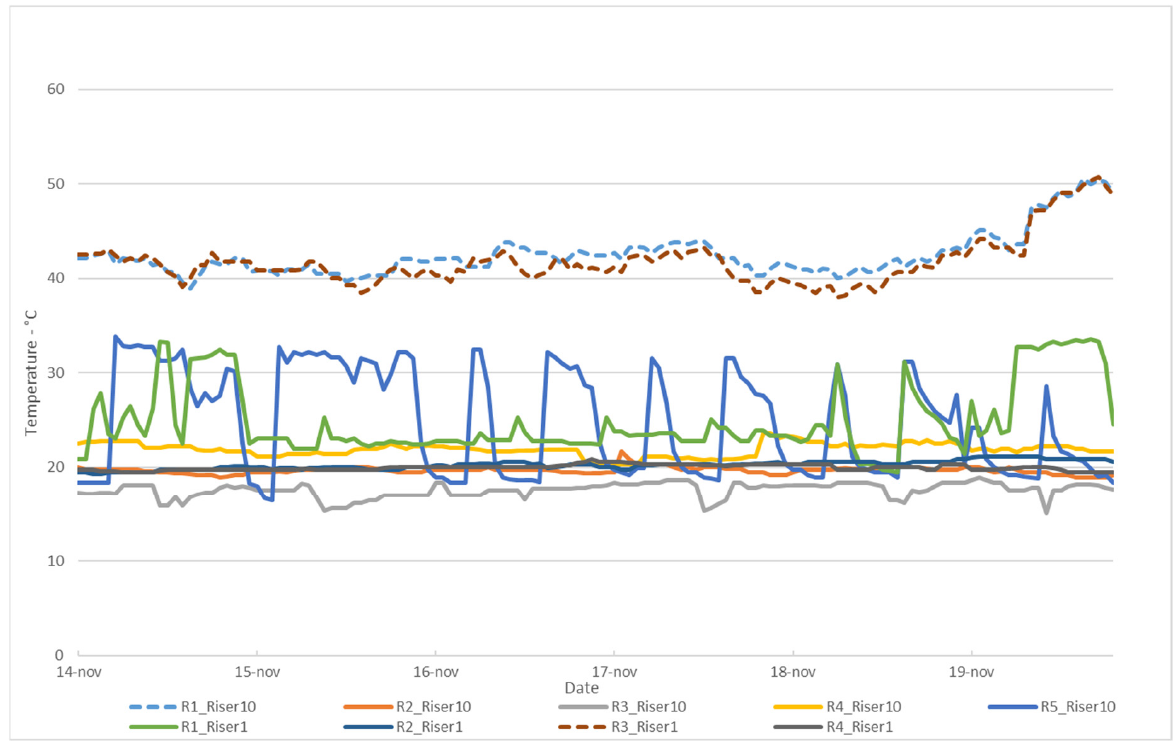
Figure 16. Return temperature measurements from the radiators connected to risers 1 and 10.